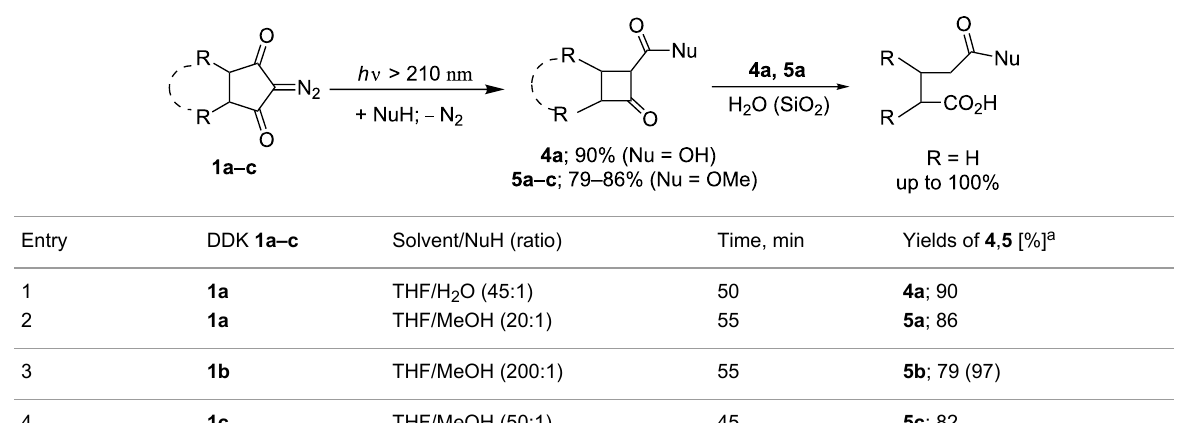
Table 2: Direct photolysis of diazodiketones 1a– с by UV light with λ > 210